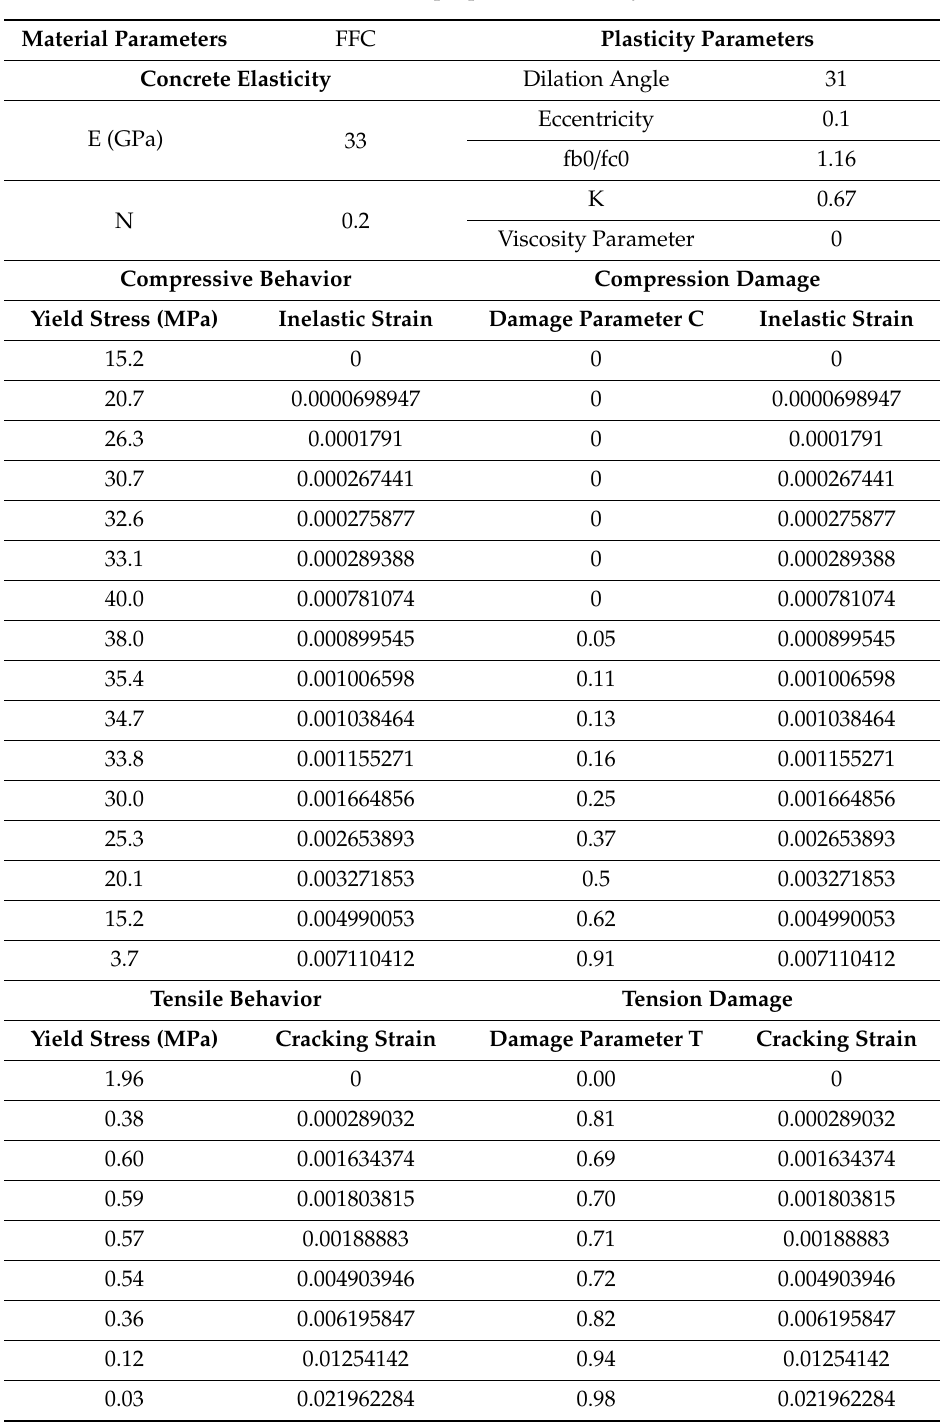
Table 7. Material properties of FFC